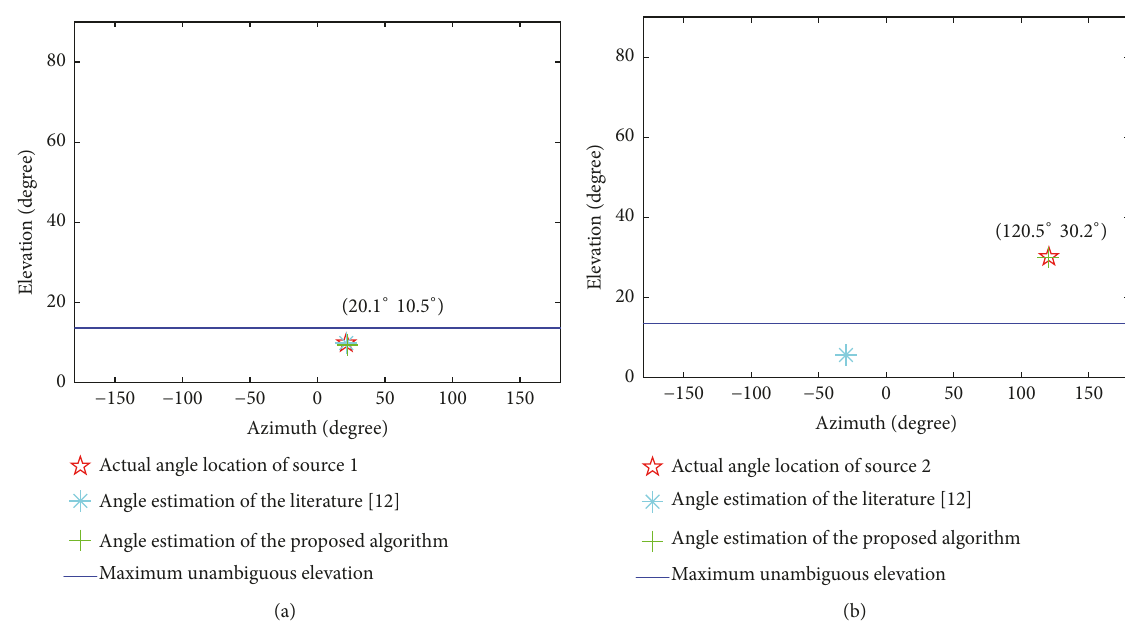
Figure 8: Comparison of source’s angle estimation. (a) Source 1. (b) Source